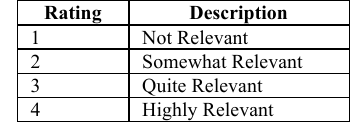
Table 1. Relevance Scale for Content Validity Indexing